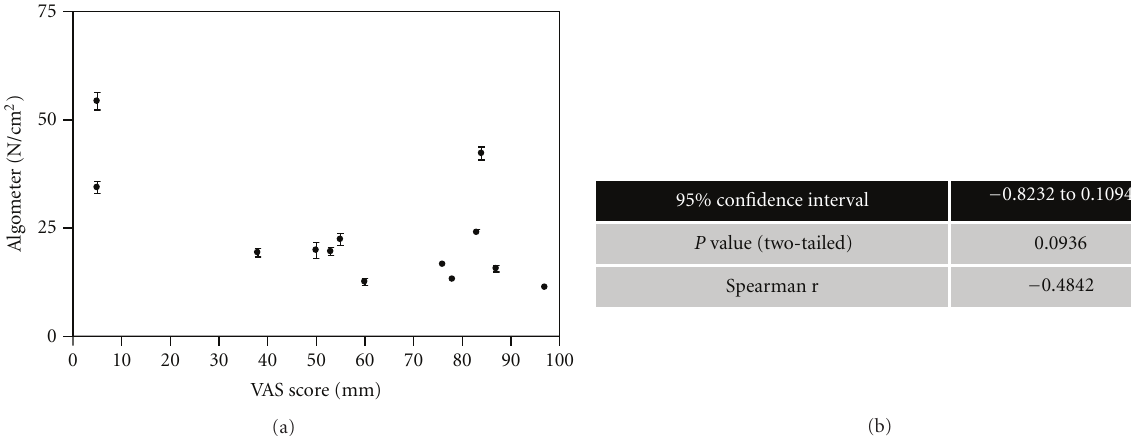
Figure 3: Correlation analysis between VAS and algometer scores. A correlation plot for hand OA participants between VAS scores (mean ± SD) and algometer scores is shown. Spearman correlation analysis for statistical significance is shown. A significant di ff erence between groups was considered at P ≤ 0 .